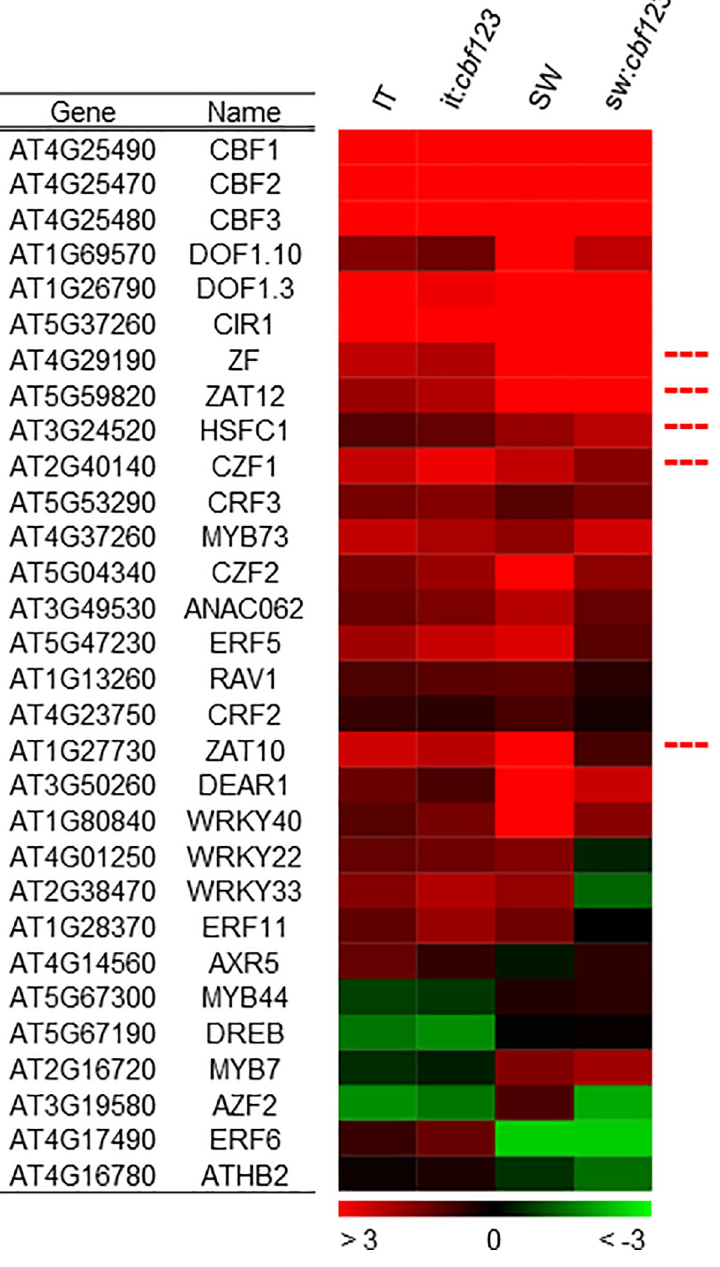
Fig 5. Cold-induced expression of “first-wave” transcription factor genes in SW, IT and their respective cbf123 triple mutants. Transcript levels of 27 first-wave transcription factor genes of Arabidopsis Col-0 [14] in the IT, SW, and cbf123 triple mutant plants after exposing plants to 4˚C for 24 h. Fold change (log 2 = 1) in transcript levels is shown comparing transcript levels to those in plants grown at 22˚C. The dotted red lines indicate genes encoding transcription factors that have been shown to induce the expression of one or more CBF regulon genes